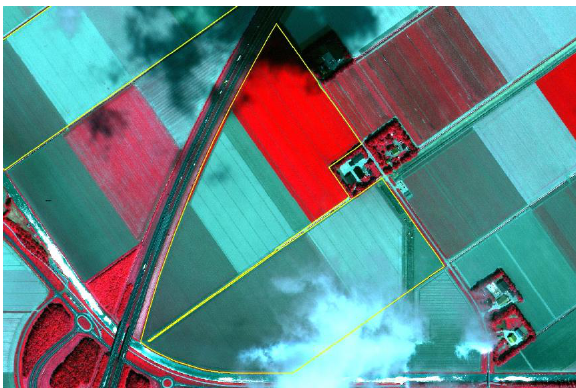
Figure 5. The selected reference parcel can’t be inspected because of clouds.